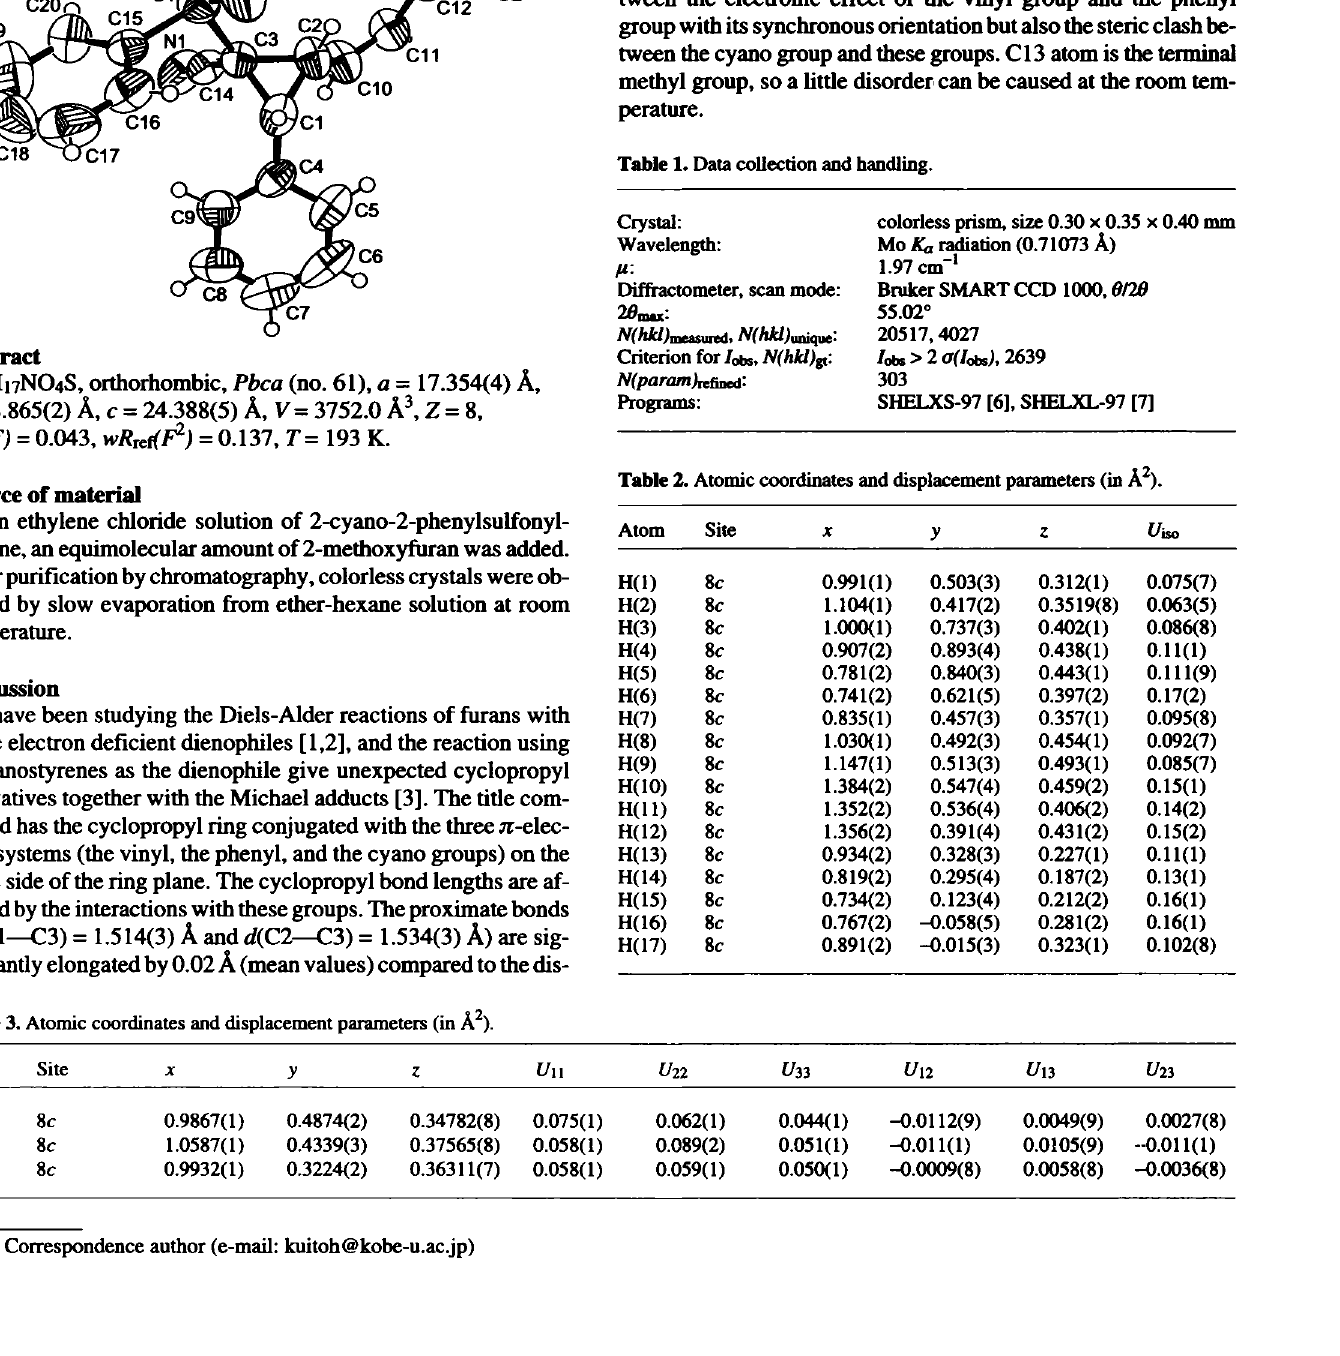
Table 1. Data collection and handling. Crystal: